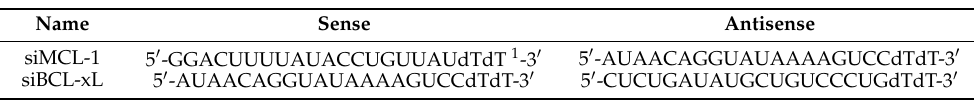
Table 1. Sequences of